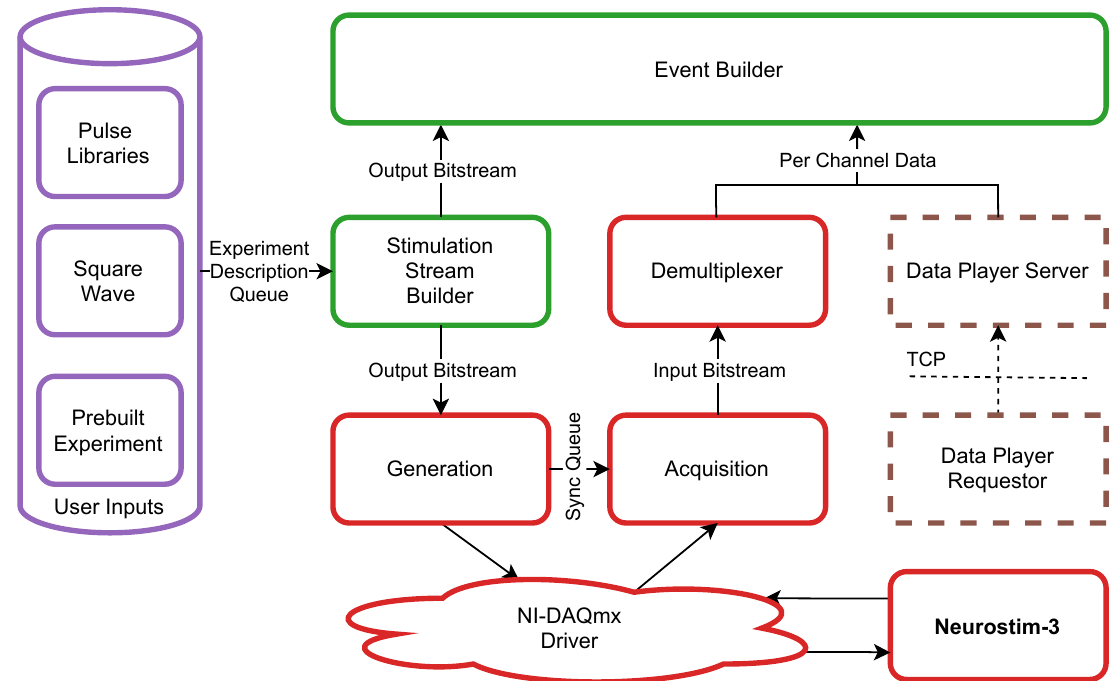
Figure 7. View of the bitstream generation and acquisition stages. The contents of the Output Bitstream depend on the required Neurostim-3 ASICs’ configuration and defined stimulation protocol — it is then sent over NI-DAQmx Driver to the Neurostim-3. Acquisition step actively awaits for the Input Bitstream , however, such data must be decoded by Demultiplexer in order to obtain Per Channel Data . Alternatively, it is possible to run the Server Application by replaying already archived datasets even without the presence of the